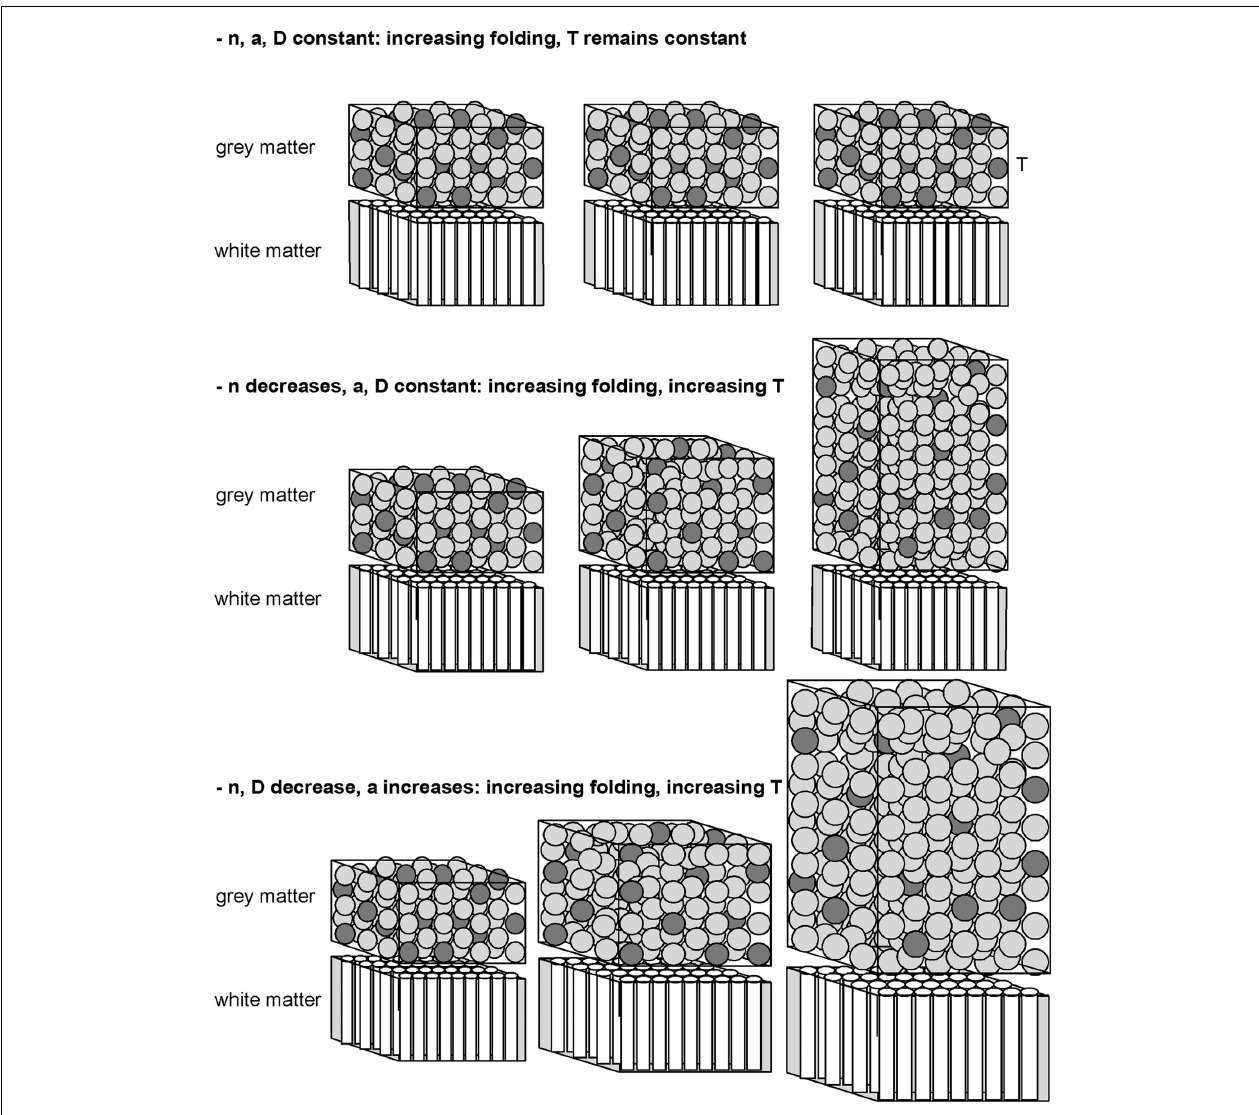
unchanging thickness given that, in this scenario, d is also 0. In the middle scenario , in which the connectivity fraction decreases but α = d = 0, cortical folding will increase, with an accompanying increase in thickness that scales with N – c (from t =− c − d − α ). In the bottom scenario , in which the connectivity fraction decreases ( c < 0) and both average neuronal size in the gray matter and axonal cross-sectional area in the white matter increase with N (that is, d < 0 and α > 0), cortical folding increases with a rapid increase in thickness that scales with N − c − d − α